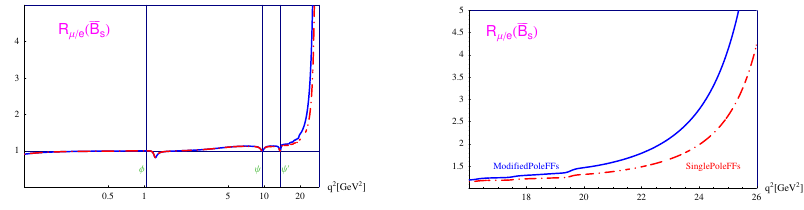
(cid:26) + (cid:26) − γ decays for di ff erent types of form factor parameterization: solid Figure 7. R µ/ e ratio for B s → line for modified pole parameterization and dash-dotted line for single pole parameterization